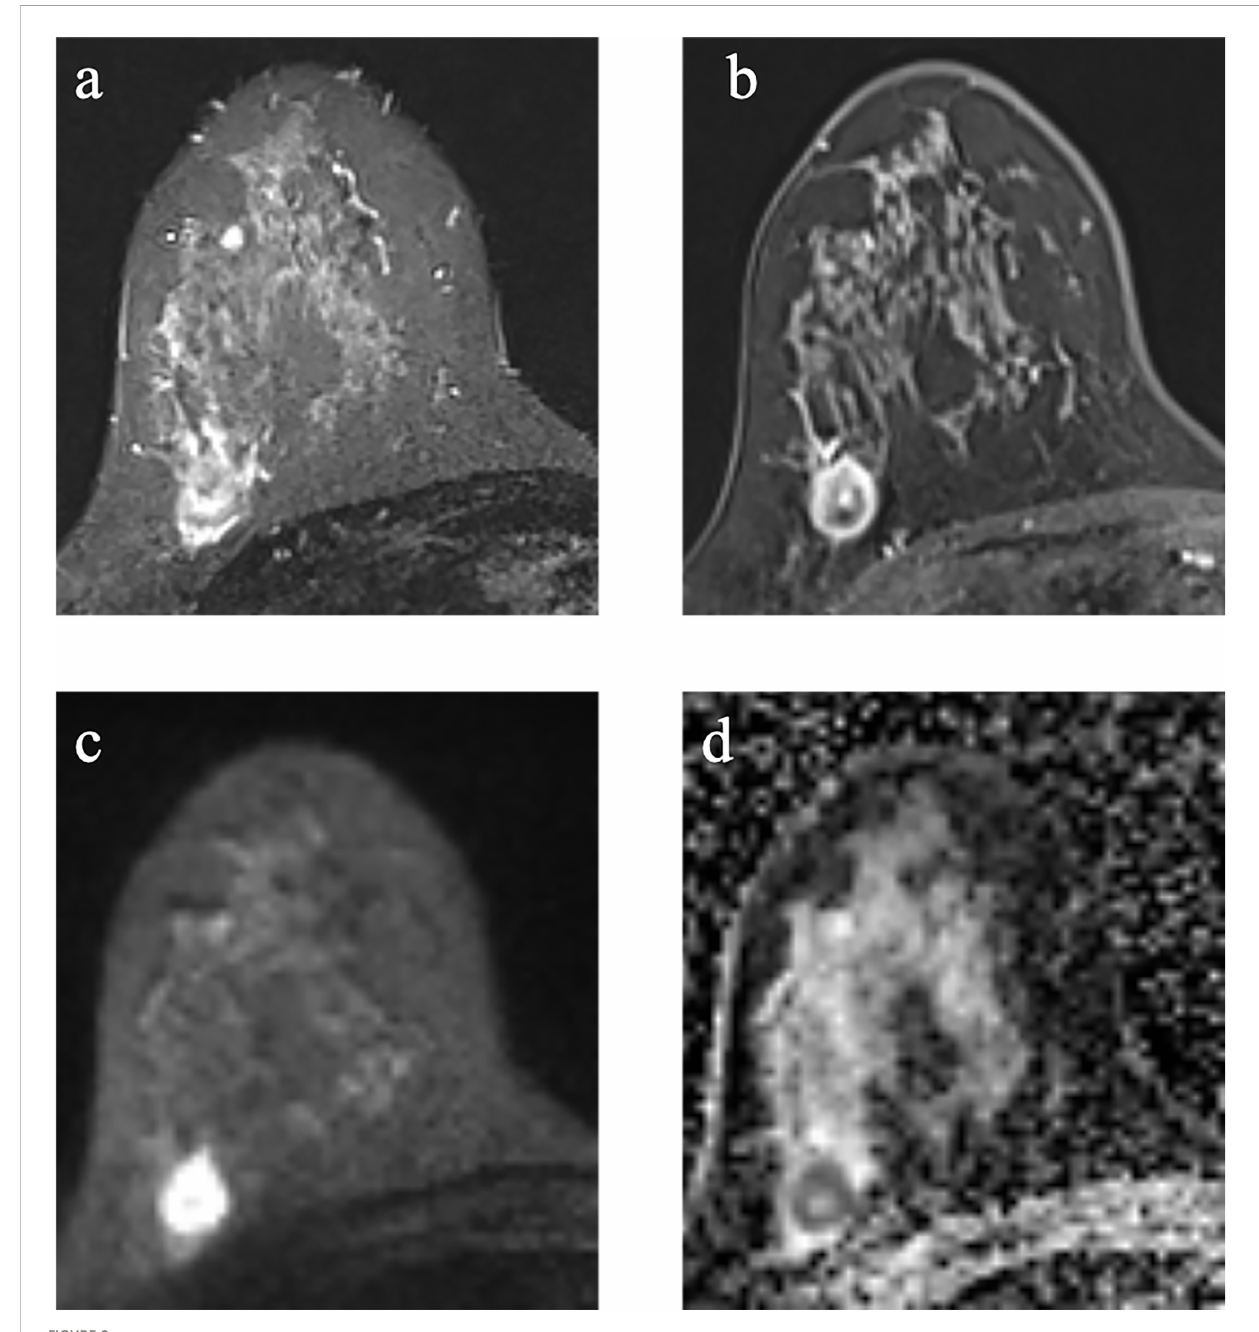
FIGURE 2 Example images of a 29-year-old woman with TNBC with TP53 mutation in the right breast (A-D) . (A) : T2-weighted-image. (B) : the fi rst phase of T1WI after contrast enhancement. (C) : diffusion-weighted image of b 1000 . (D) : apparent diffusion coef fi cient (ADC)